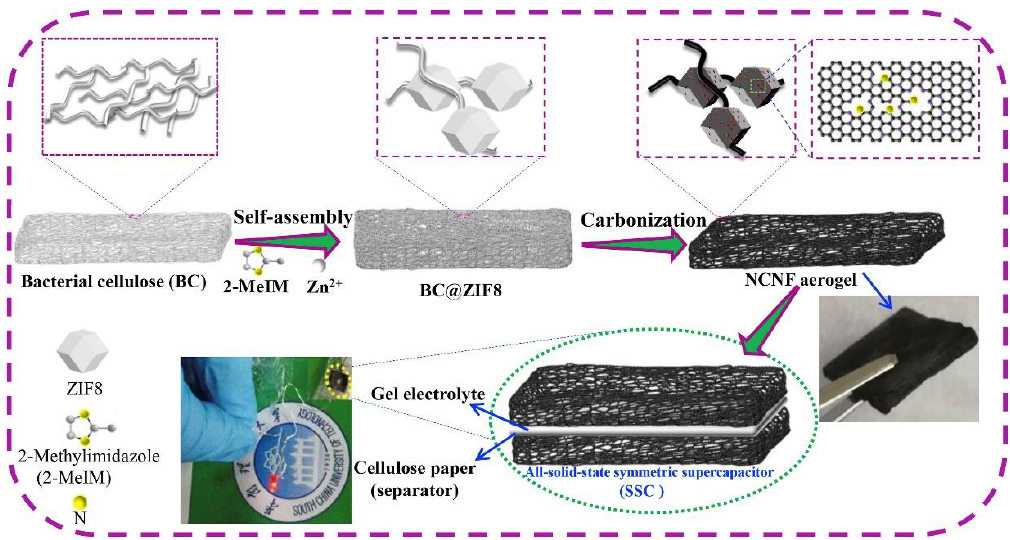
Figure 12. Manufacturing process for a supercapacitor using N-doped carbon nanofiber (NCNF) aerogels from cellulose. Reprinted with permission from [48]. Copyright © 2019 Elsevier Ltd.